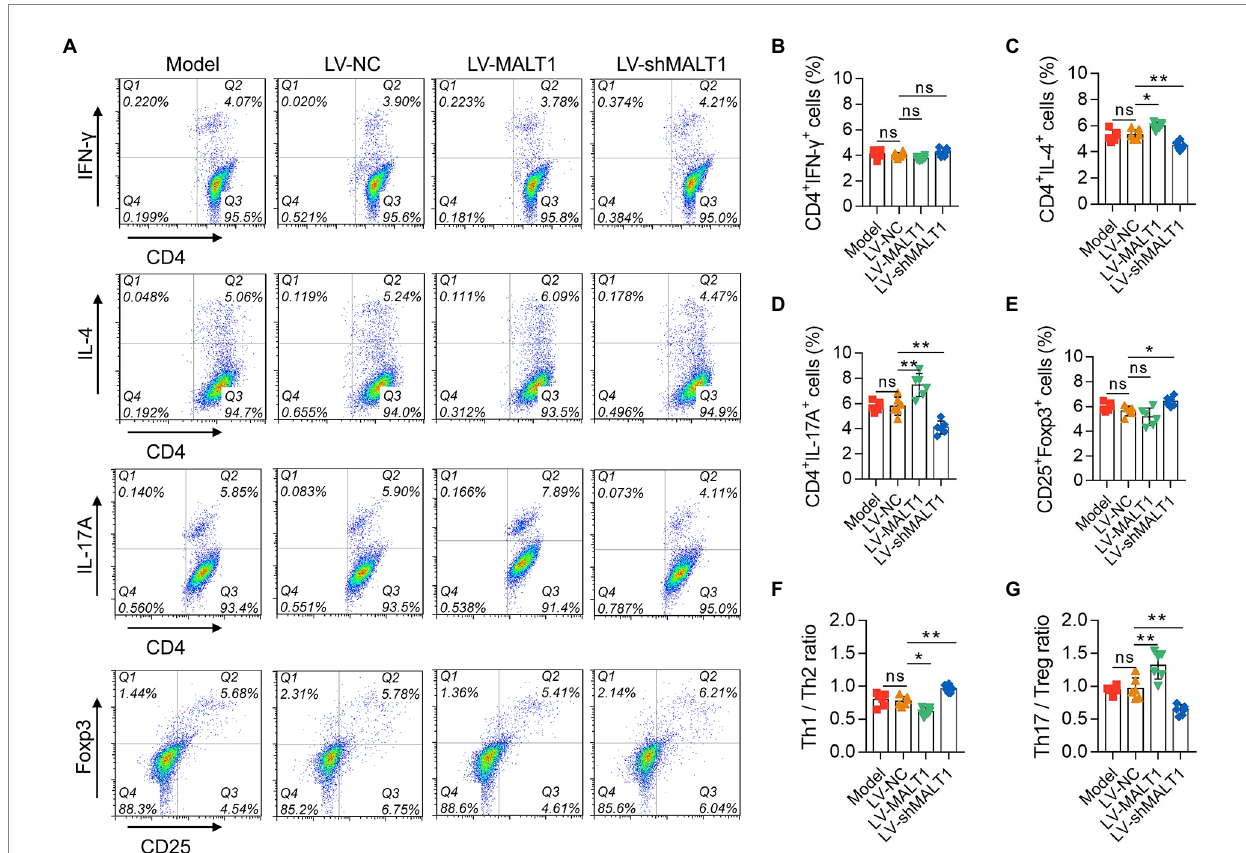
FIGURE 6 Effect of MALT1 on CD4 + T-cell polarization in LPS-induced septic mouse model. Detection of CD4 + T cells by flow cytometry (A) . Comparison of Th1 (B) , Th2 (C) , Th17 (D) , and Treg (E) cells, Th1/Th2 ratio (F) , and Th17/Treg ratio (G) among the Model, LV-NC, LV-MALT1, and LV-shMALT1 groups. n = 6 in each group. One-way ANOVA plus Tukey’s post hoc test was applied. Ns, not significant; * p < 0.05; ** p <